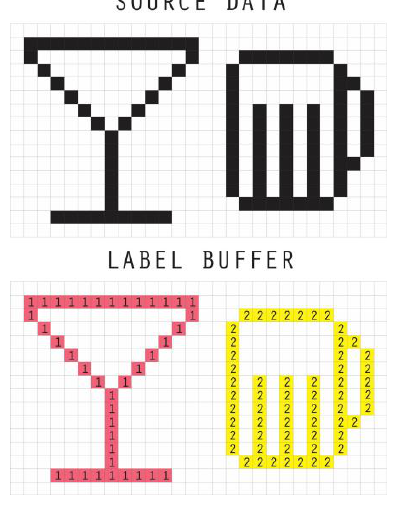
Fig. 11. Labeling example (with correct label equivalence).